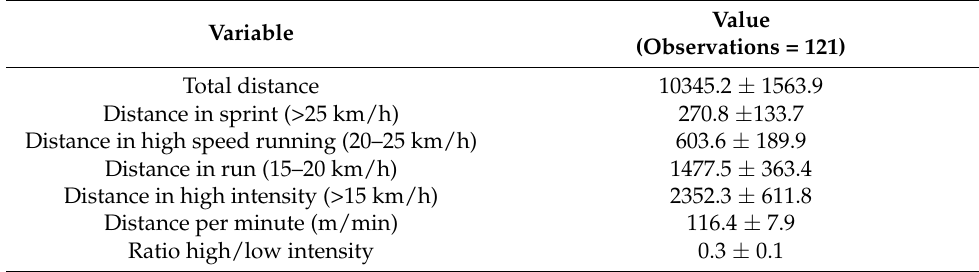
Table 2. Match reports. Distances are expressed in meters. Distance per minute is expressed in meters/minute. Values are expressed as mean ± standard